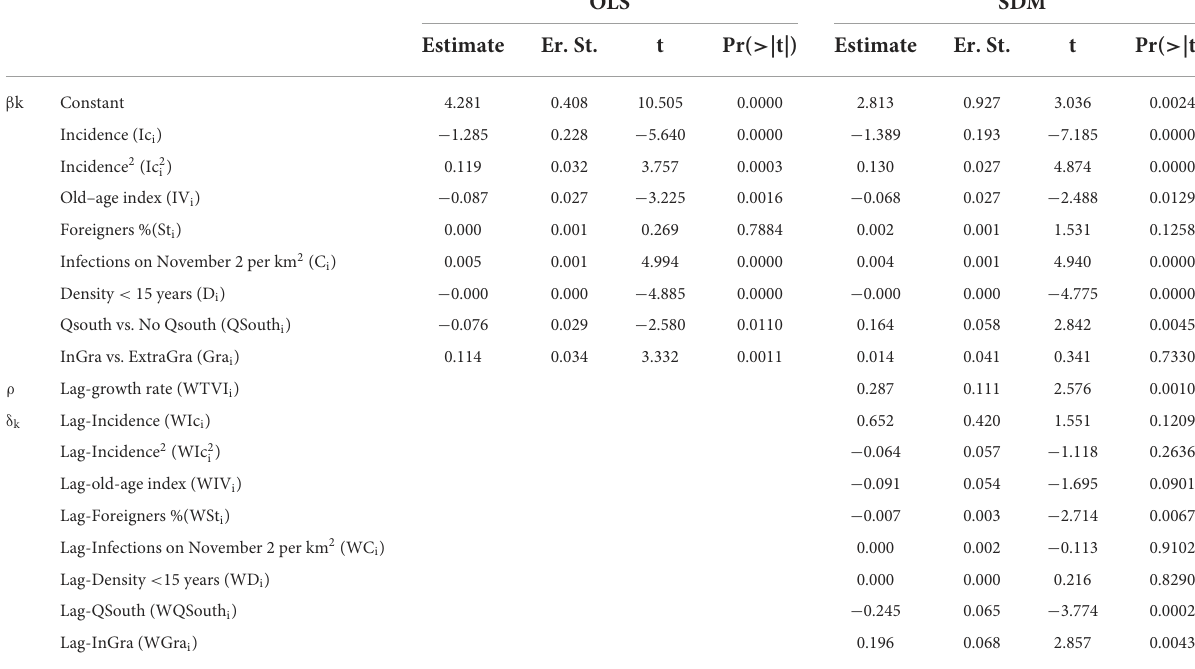
TABLE 2 Estimates of the parameters of the OLS and SDM model.